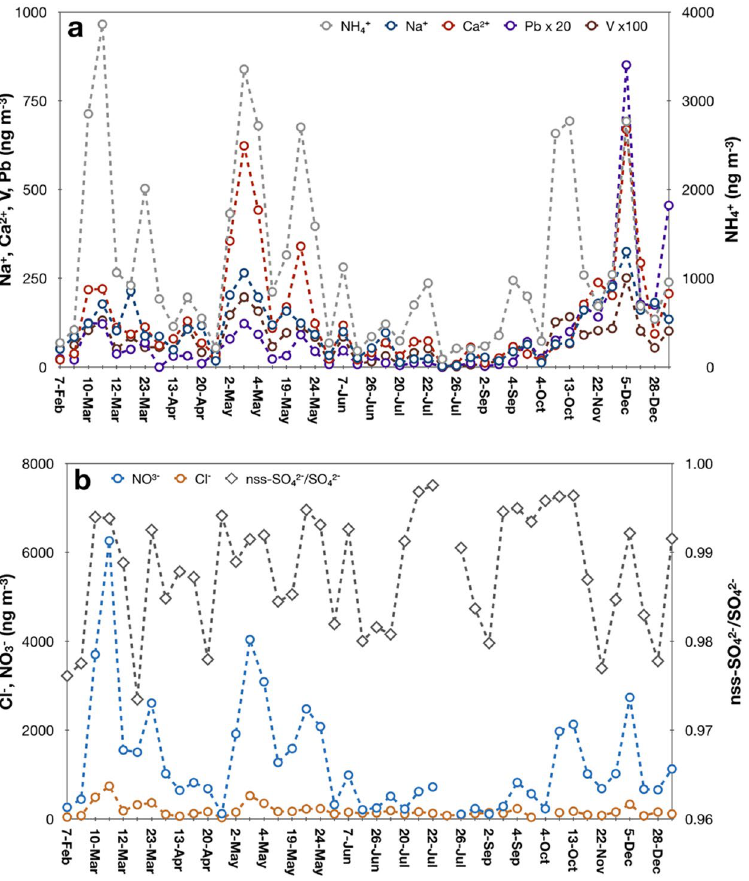
Figure 1. Time series of the concentrations (ng/m 3 ) of major ions and metals (Na + , Ca 2 + , and NH 4 + , nss-SO 4 / SO 42 − , NO 3 − , and Cl − . Pb and V). The data values are provided in Table